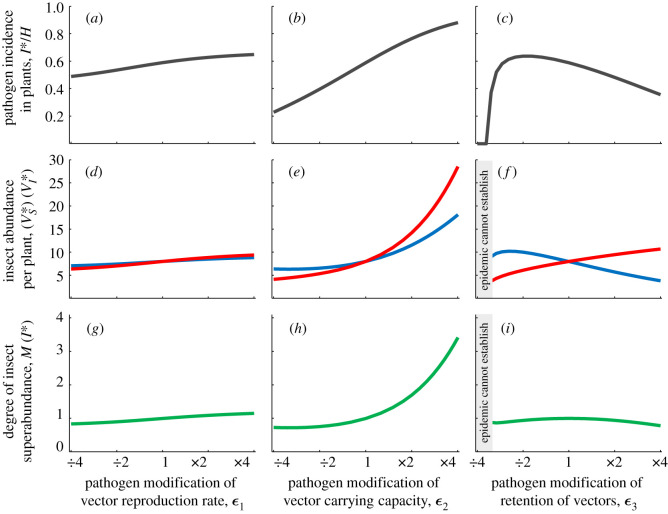
Pathosystem dynamics and insect superabundance: the consequences of pathogen modifications of plant resource quality for vector dynamics and pathogen epidemics (a–i). When the modifying pathogen is endemic, different levels of modifications (x-axis) lead to (a–c) different values for pathogen incidence among plants; (d–f) different values of vector abundance per healthy (blue curves) and per infected (red curves) plant; (g–I) different values for the degree of vector superabundance (green curves). (a–i) were generated with K = 10 over a host plant population size of H = 1000; rates per day were a = 1, μ = 1/5, racq = 1/2, rinoc = 1, δ = 0.3, θ = 2 and σ = 2.